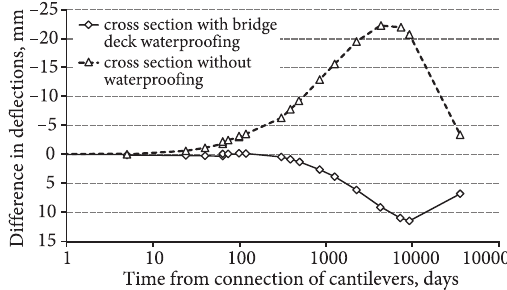
fig. 6. Final relative deflection at mid-span